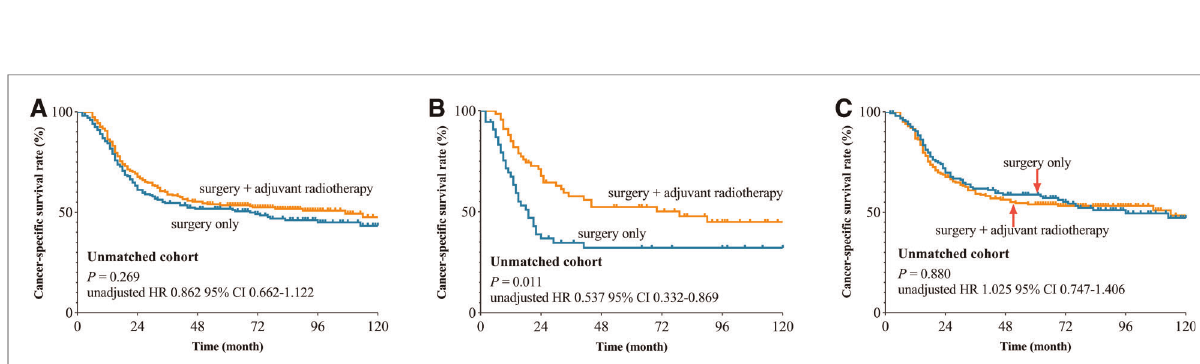
FIGURE 2 Cancer-speci fi c survival curve for oral cavity squamous cancer patients with stage T1-2N1M0 according to the treatment approaches in the matched cohort of Surveillance Epidemiology and End Results database. ( A ) Whole cohort, ( B ) patients with lymph nodes examined ≤ 16, and ( C ) patients with lymph nodes examined >16).